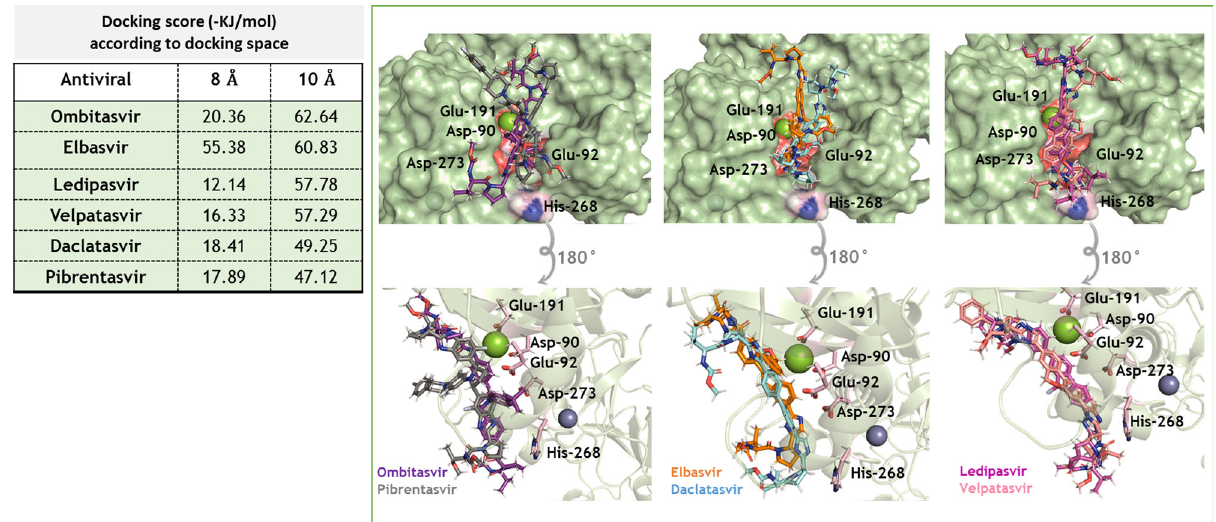
Fig. 2 3D representation of the best docking poses for HCV NS5A inhibitors in the nsp14 exonuclease active site. The NS5A inhibitors were built and minimized in terms of energy by density functional theory (DFT). Docking was performed using GOLD 2020.2 software with ChemPLP as scoring function. Because of the diversity in NS5A inhibitors ’ molecular weights, they were allowed to dock within 8 or 10 Å spheres in the SARS-CoV-2 nsp14 exonuclease active site, constructed in Supplementary Fig. S-2. The NS5A and catalytic amino acid residues are in stick representation. Mg ++ and Zn ++ are represented as green and indigo blue spheres,